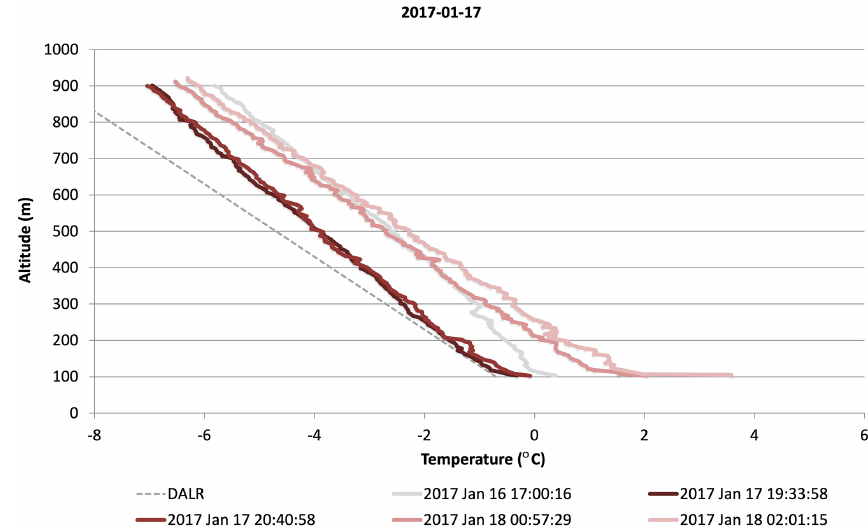
Figure 6. SUMO observed temperature profiles (colored lines) near Lake Vanda in the Wright Valley from 17:00UTC, 16 January 2017, to 02:01UTC, 18 January 2017. The dry adiabatic lapse rate (DALR) is shown with a dashed gray line.